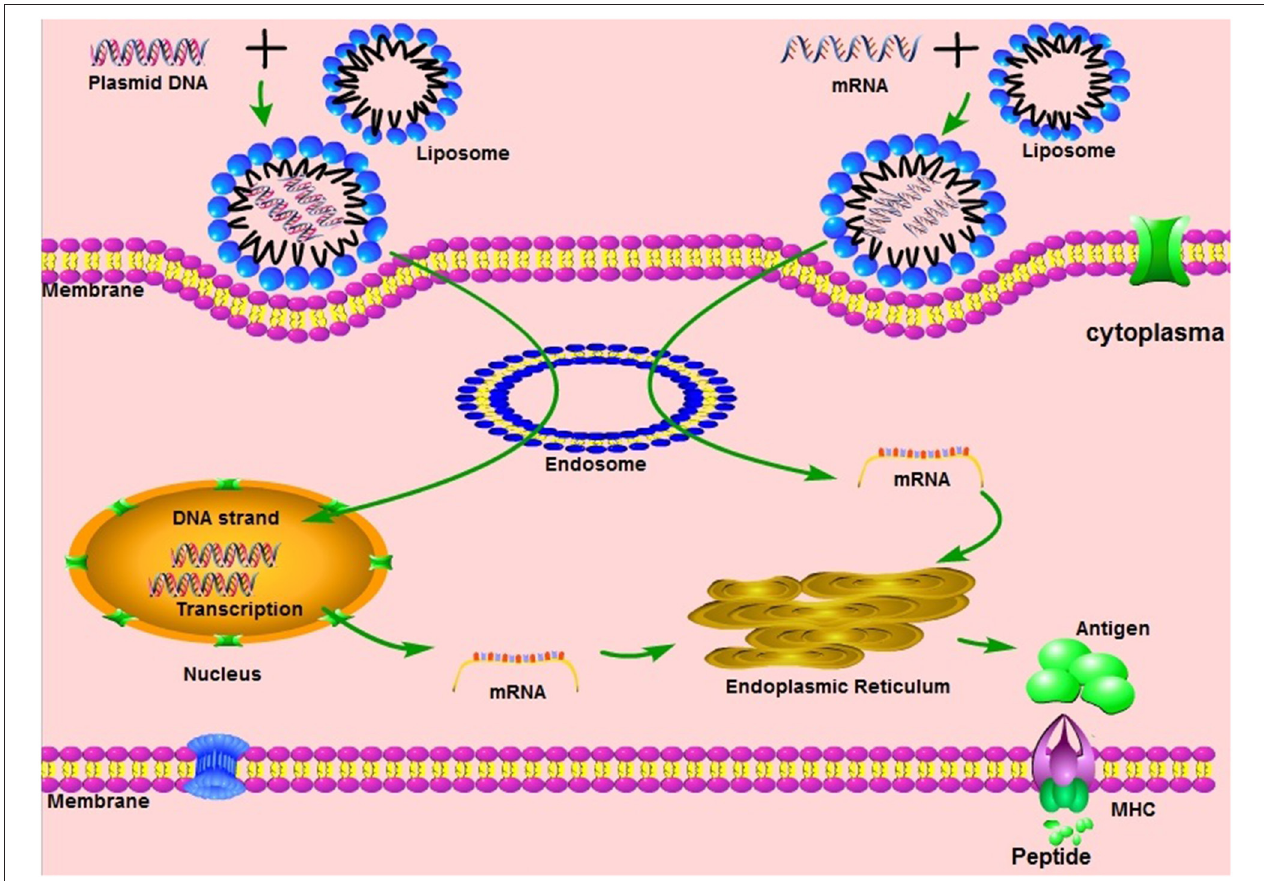
FIGURE 1 | The mechanisms of different nucleic acid vaccines, including DNA vaccines, mRNA vaccines. MHC, Major histocompatibility complex.